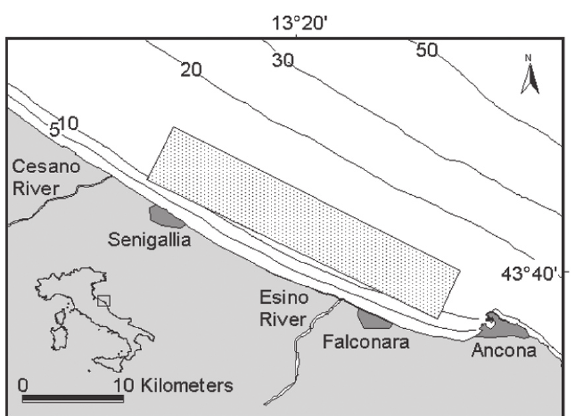
Fig. 1. – Map of the study area in the north-central Adriatic